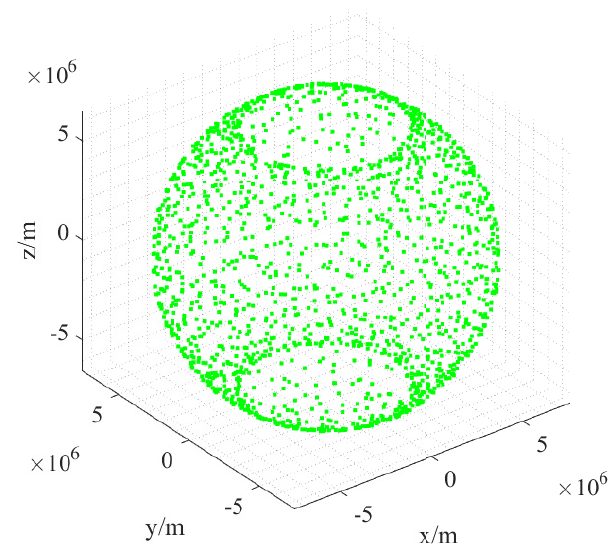
Figure 20. Final distribution of the mega constellation.